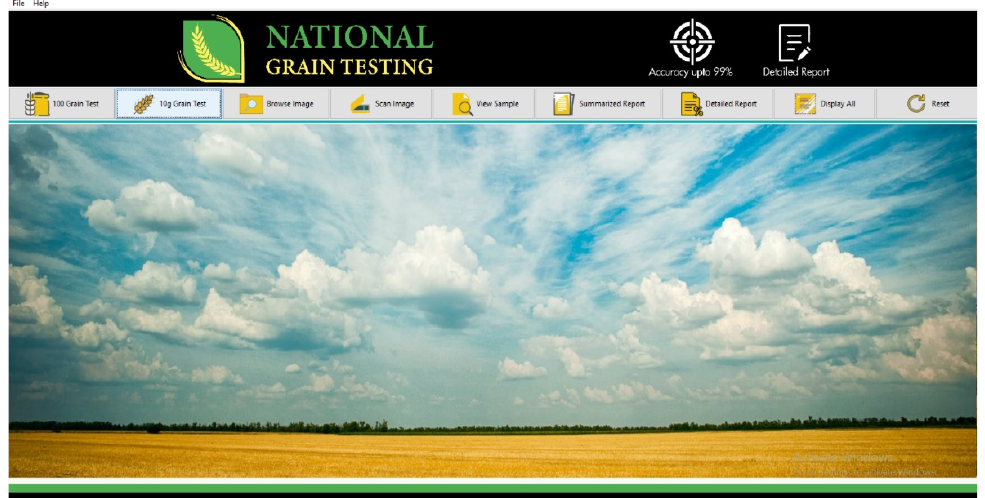
Figure 14. Front-end view of the desktop application.